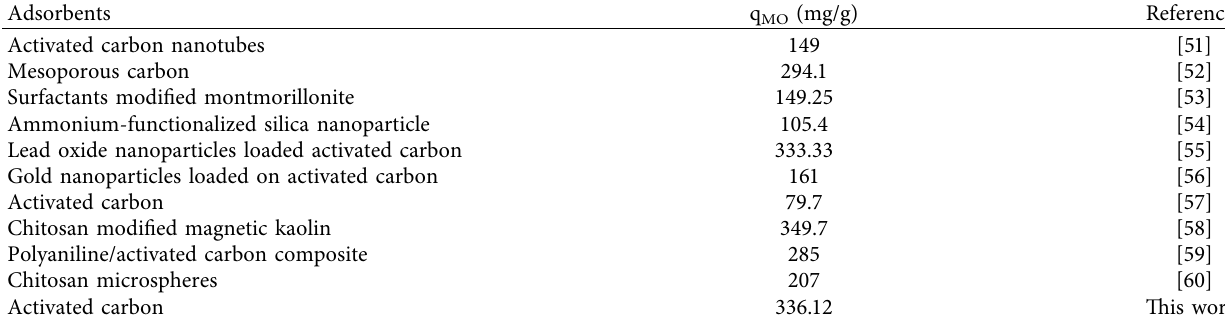
Table 5: Adsorption capacities of MO onto various